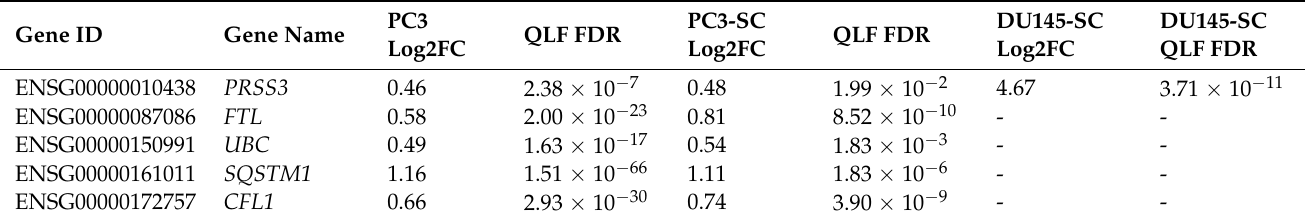
Table 7. Differential expression of PRSS3, FTL, UBC, SQSTM1 and CFL1 genes.